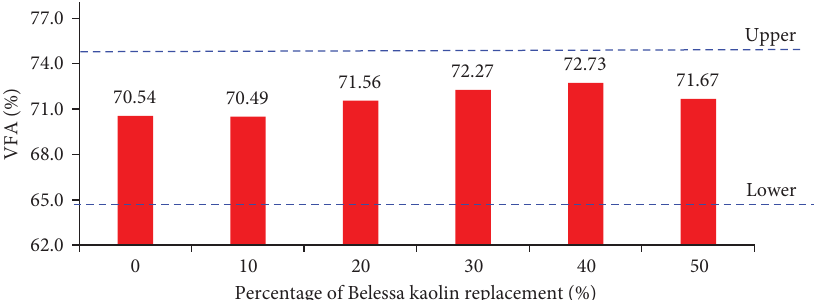
Figure 10: Relationship between VFA and replacement proportion of Belessa kaolin at OBC.